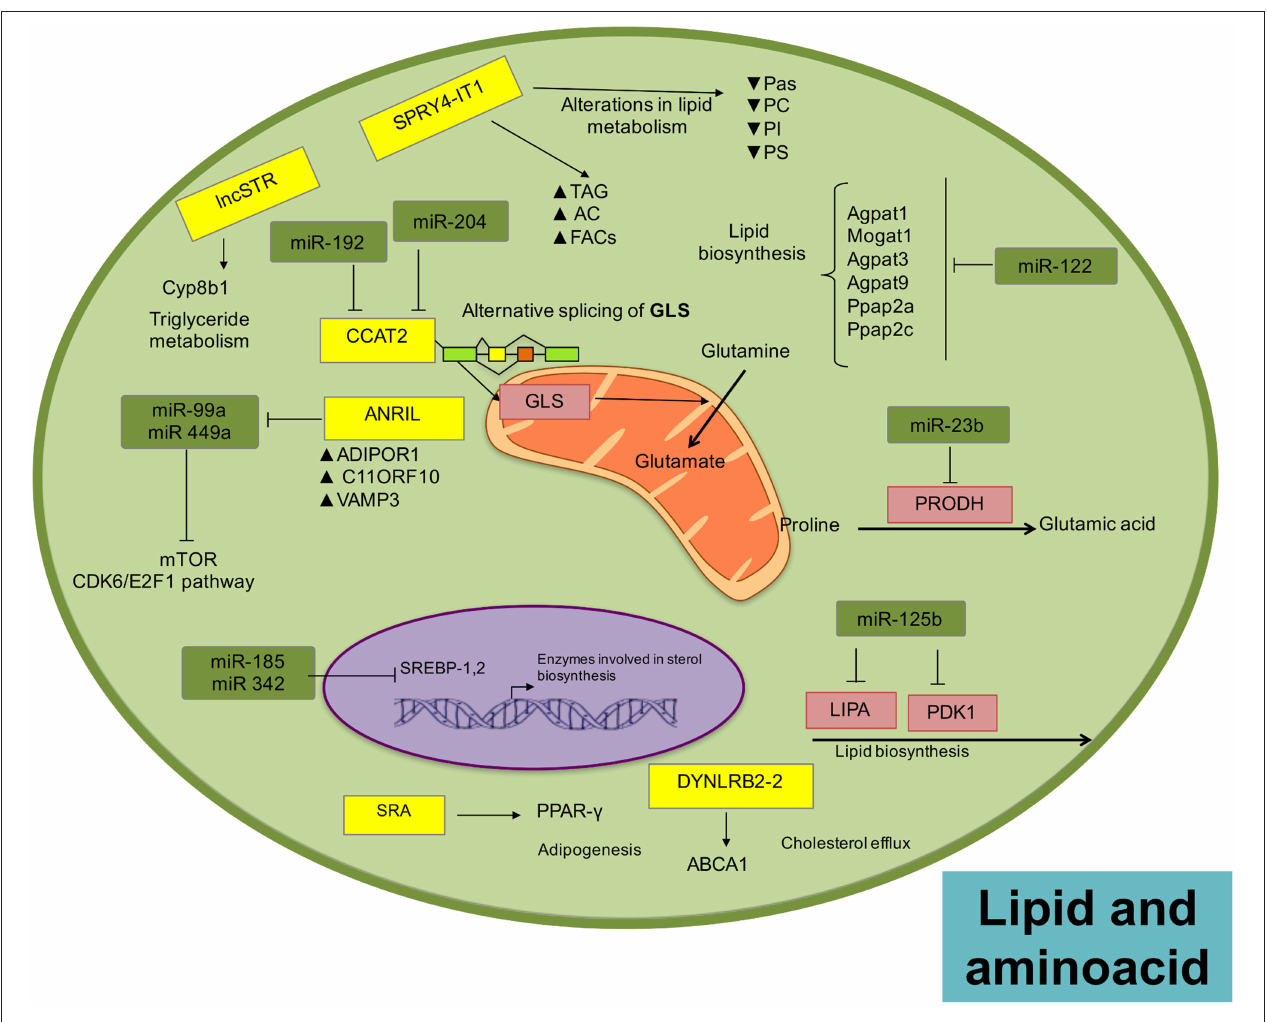
FIGURE 3 | Landscape of lipid and amino acid metabolism regulated by ncRNAs in tumors. Micro and lncRNAs can regulate the metabolism of amino acids through the regulation of enzymes related with these metabolic pathways, favoring the disposition of amino acids as important sources of energy. There is also a fine regulatory loop between microRNAs and lncRNAs than can actively impact metabolic